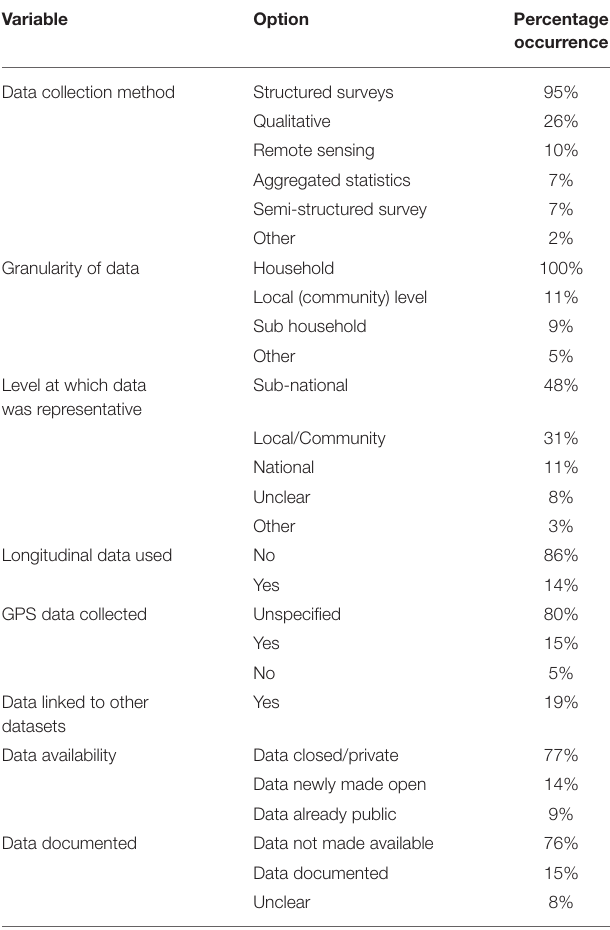
TABLE 3 | A summary of the data used in articles examined during the full article review ( N =